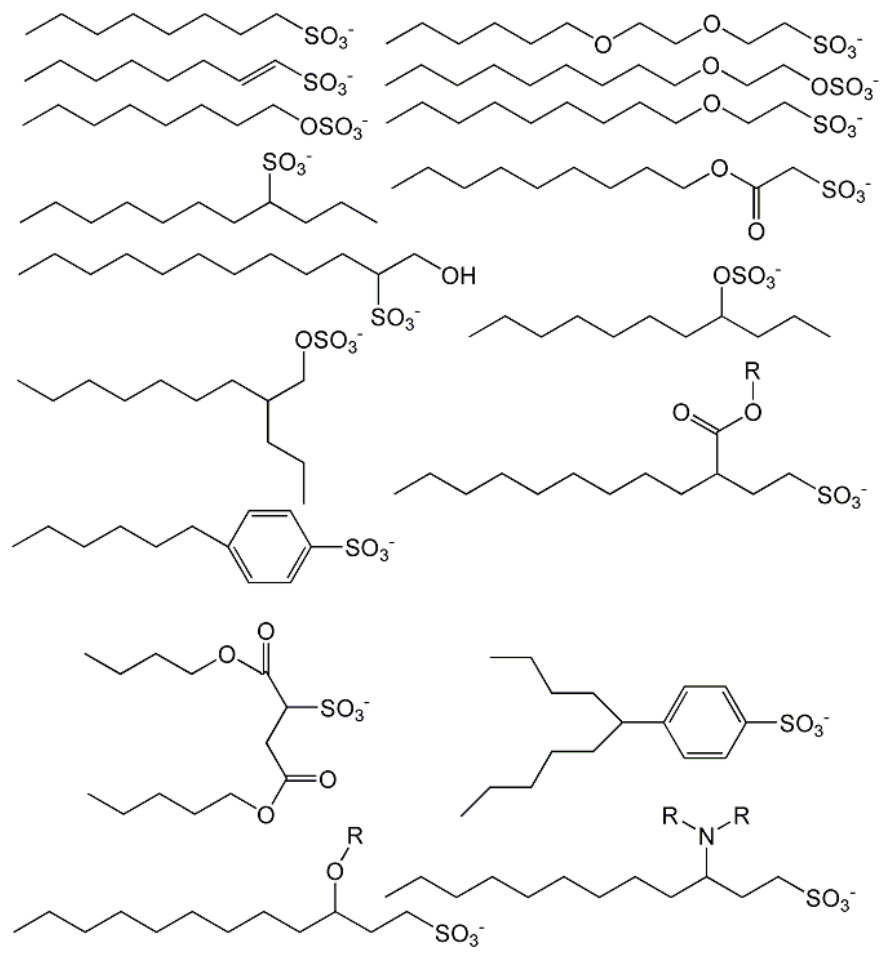
Figure 2. Representative structures of the anionic surfactants, showing the diversity of the hydrophilic and hydrophobic domains